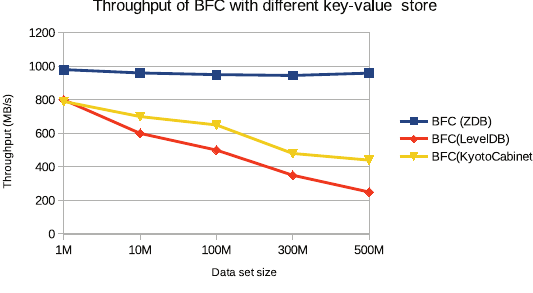
Fig. 9. Throughput of BFC when using different key-value store